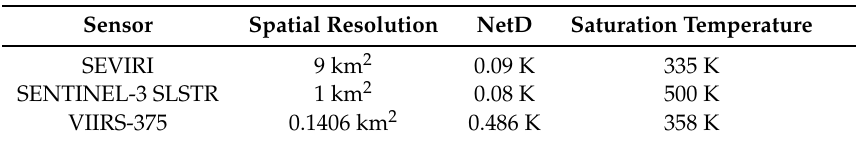
Table 1. Main satellite sensors